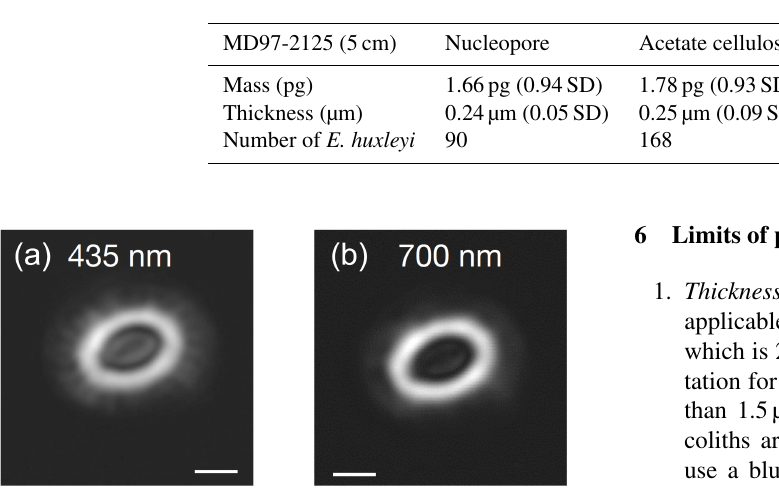
Table 3. Average morphology results of population of Emiliania huxleyi coccoliths measured on three different supports.